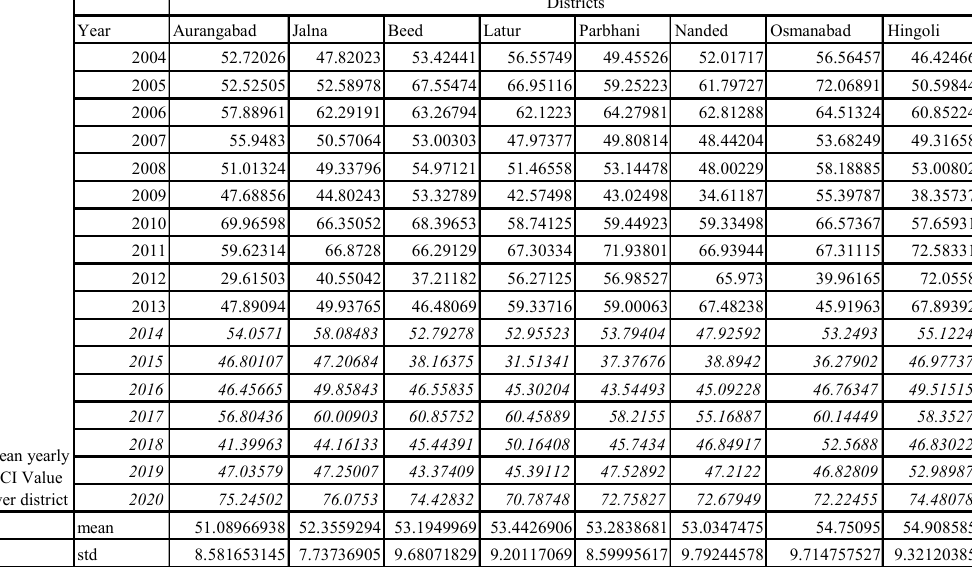
Table 3: Annual mean SCI over every district of Marathwada from 2004 to